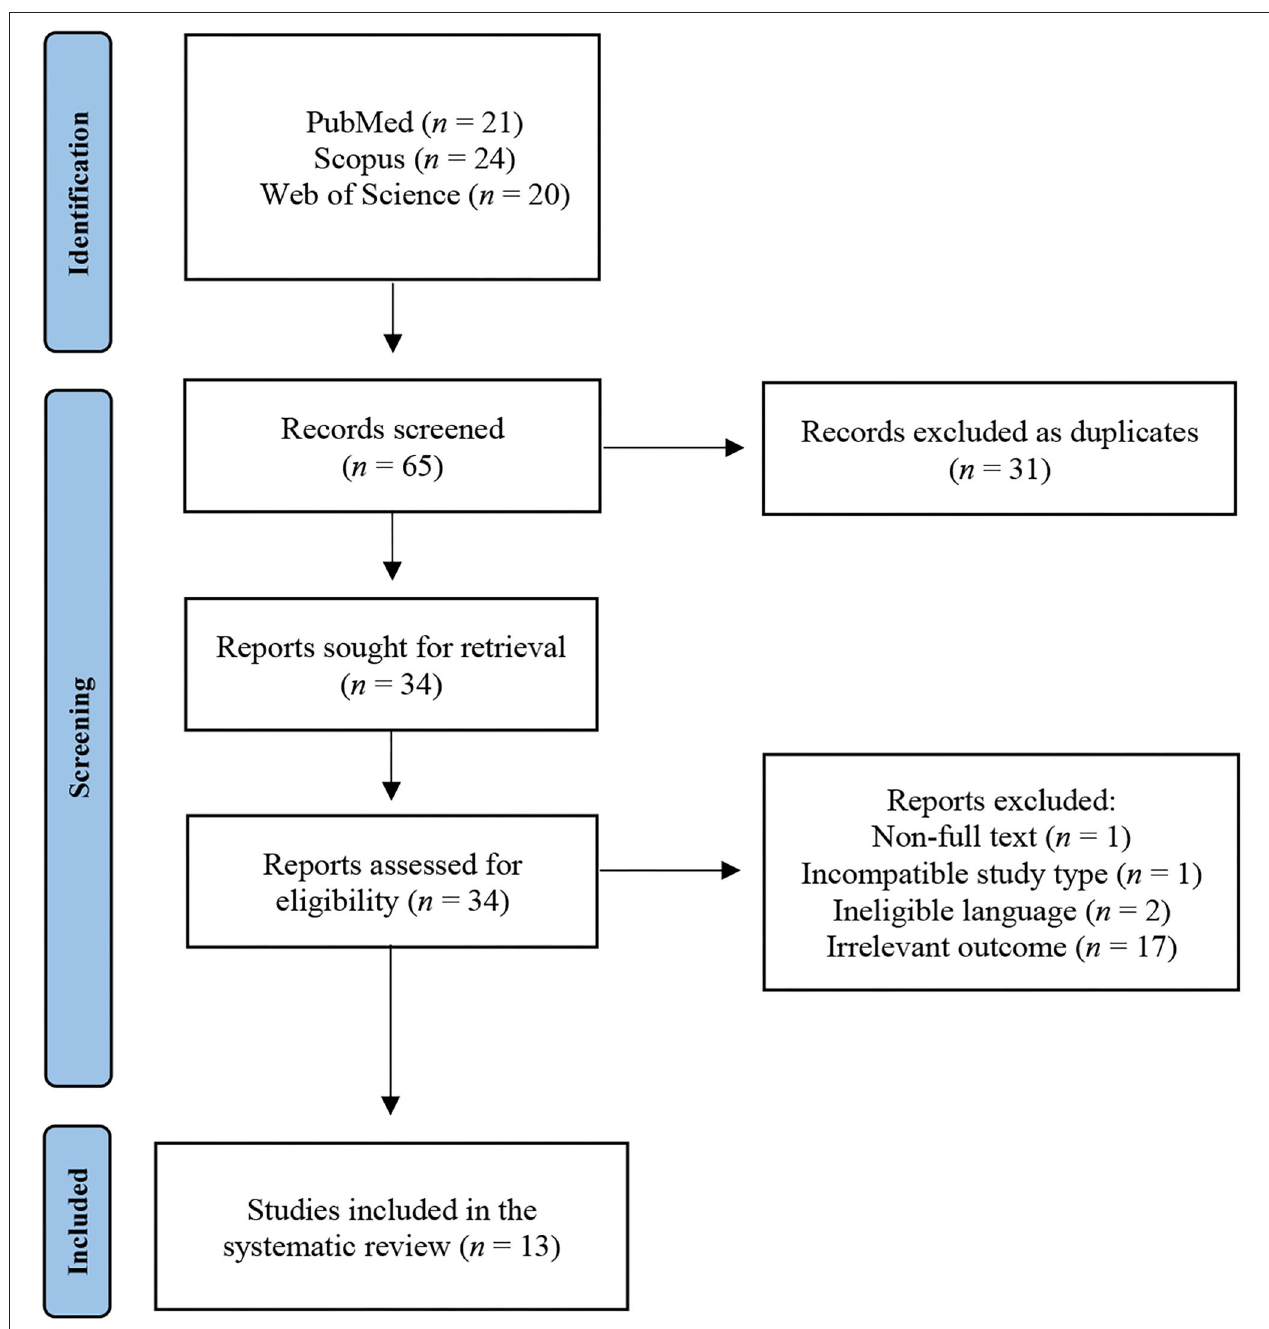
FIGURE 1 | Flowchart of the employed literature search.